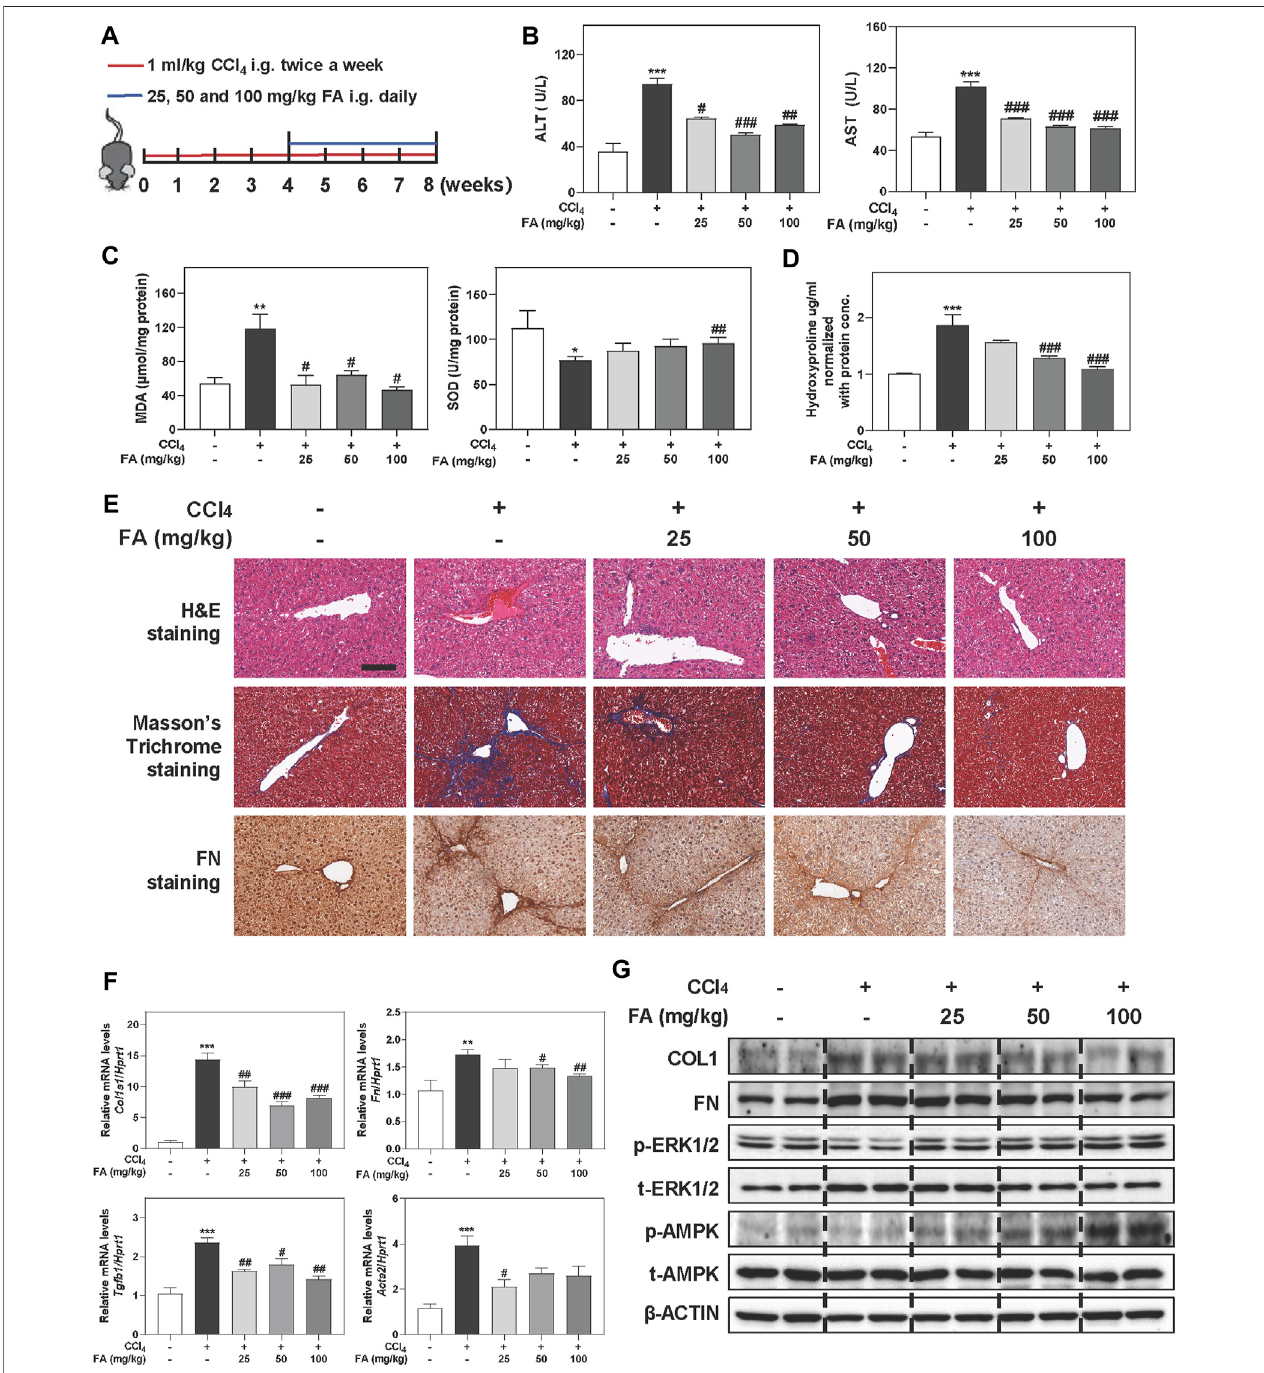
FIGURE 1 | FA alleviates CCl4-induced fi brotic injury in mice. Mice were received with CCl 4 (1 ml/kg) and different dosages (25, 50, and 100 mg/kg) of FA by gavage. (A) Schematic diagram of in vivo experiments that linked FA with anti- fi brotic therapies. (B) ALT and AST levels in serum. (C) MDA and SOD levels in livers. (D) Measurement of the liver hydroxyproline. (E) Representative images of H & E, Masson ’ s Trichrome and FN staining. Scale bar (cid:1) 100 μ m. (F) Relative mRNA levels of Col1a1, Fn, Tgfb1 and Acta2 were determined by qPCR and normalized using Hprt1 as an internal control. (G) Representative immunoblots against COL1, FN, p-ERK1/2, t-ERK1/2, p-AMPK, t-AMPK and β -ACTIN were shown. Statistical signi fi cance: * p < 0.05, ** p < 0.01, *** p < 0.001, compared with control group; # p < 0.05, ’ s post-hoc tests ( n (cid:1) 6). ## p < 0.01, ### p < 0.001, compared with CCl 4 group. One-way ANOVA with Tukey